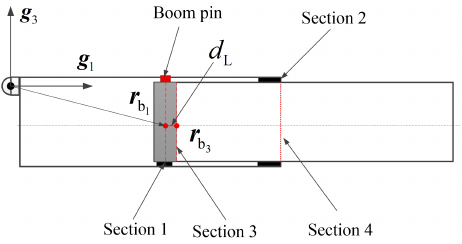
Figure 7. Overlap point of two boom